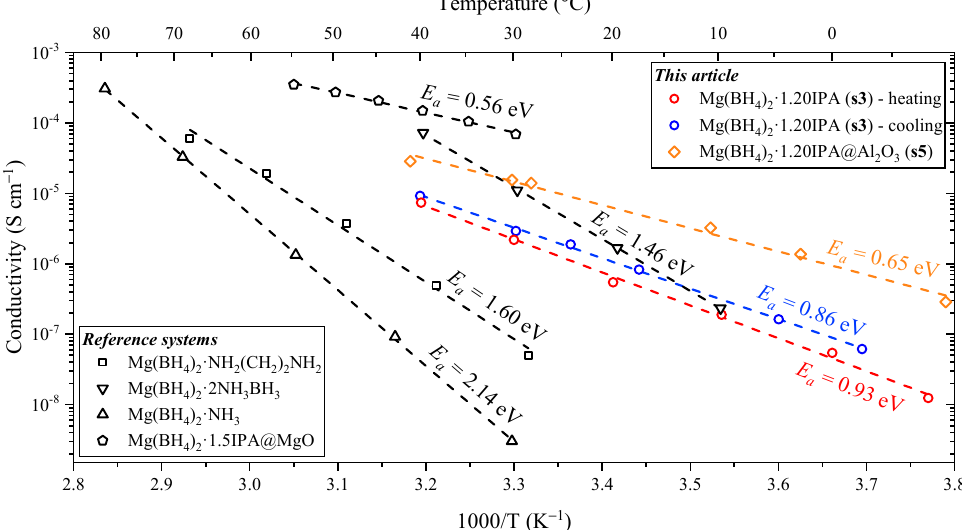
Figure 6. Magnesium (Mg 2+ ) ionic conductivity as a function of temperature measured by electrochemical impedance spectroscopy (EIS) of Mg(BH 4 ) 2 ∙ (CH 3 ) 2 CHNH 2 ( s3 ) during heating from − 7.9 to 40 °C (data shown as circles). The same sample ( s3 ) was then heated and cooled three times between 30 and 40 °C before being cooled to − 2.6 °C and measured by EIS during heating to 40 °C (open spheres). Nyquist plots of Mg(BH 4 ) 2 -1.20IPA-Al 2 O 3 ( s5 ) are provided in Figure S6. Magnesium ionic conductivity data and activation energies of Mg(BH 4 ) 2 ∙ NH 2 (CH 2 ) 2 NH 2 , Mg(BH 4 ) 2 ∙ NH 3 and Mg(BH 4 ) 2 ∙ 2NH 3 BH 3 , and of Mg(BH 4 ) 2 ∙ 1.5IPA − MgO are also included for comparison (data from refs. [6,7,9,22]).